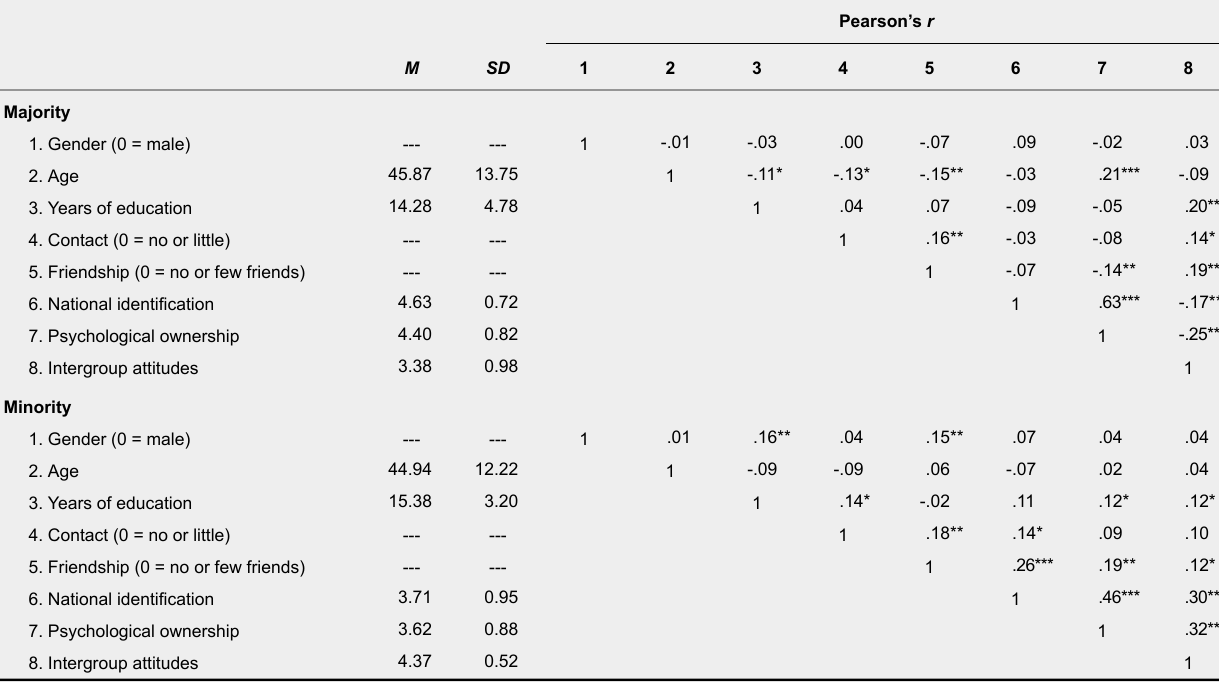
Descriptive Statistics and Pearson’s Correlation Coefficients for the Variables Used in the Study among Majority (n = 334) and Minority (n = 313)